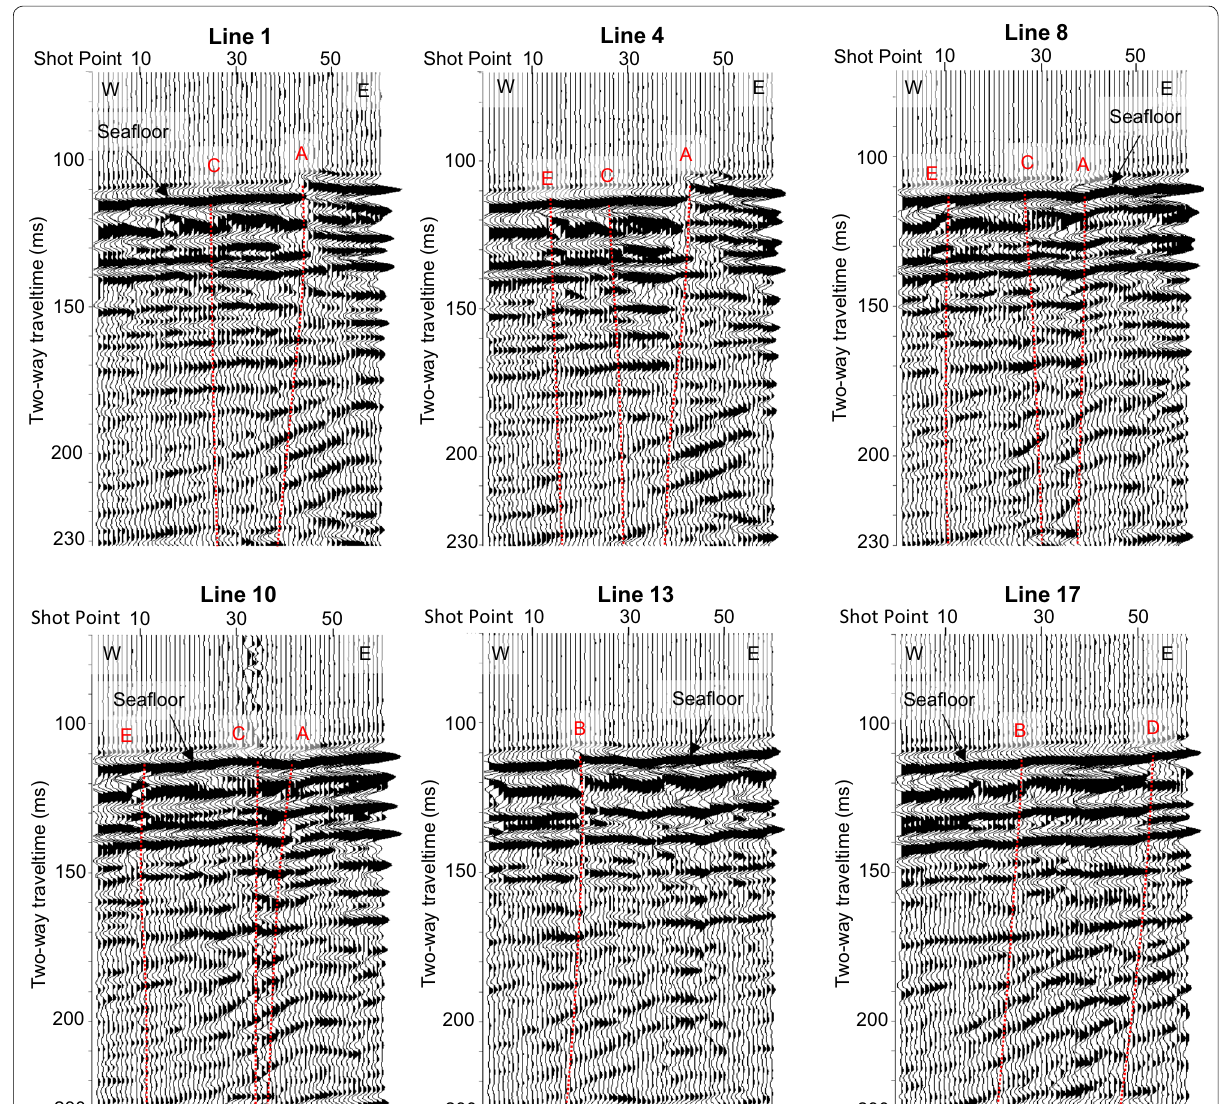
Fig. 2 Six MCS profiles are shown. Five faults are interpreted by red dotted lines on the profiles. Faults A and B clearly cut the seafloor. Faults C, D, and E cut the reflections immediately below the